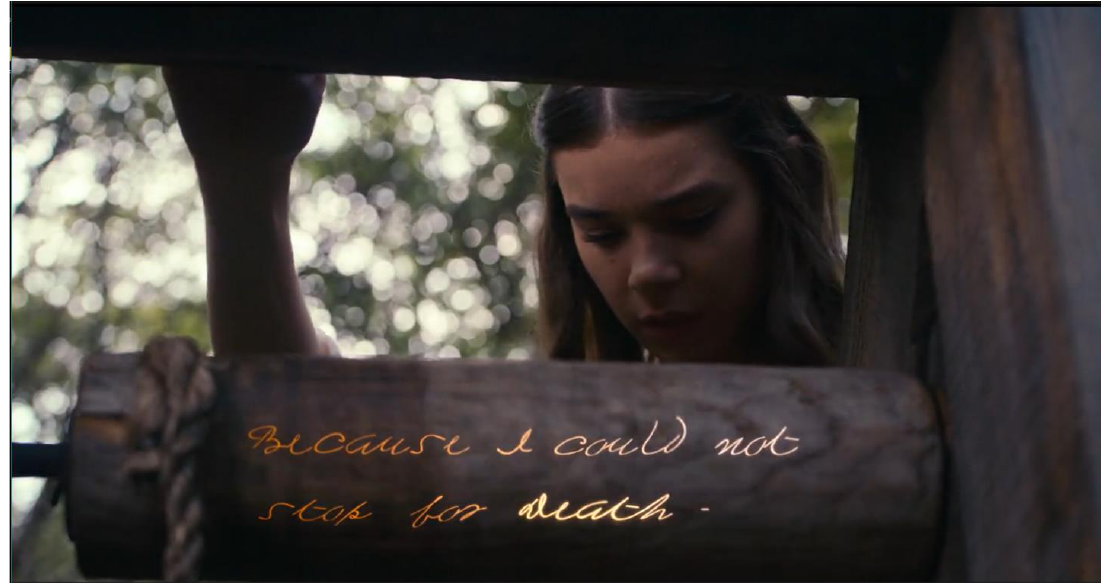
Figure 1. Handwritten lines of Dickinson’s poetry denote the ephemerality of the written word. Many critics note approvingly that the show not only portrays queer desire but ex- pands the previously reductionist view of Dickinson as an isolated, reclusive figure con- stantly clad in white dresses. The Mary Sue ’s Stefania Sarrubba finds that the show “has been working relentlessly to do right by Emily Dickinson, leaving some of the most out- dated, sexist myths about her behind” (Sarrubba 2021). Academic viewers tend to agr ee.